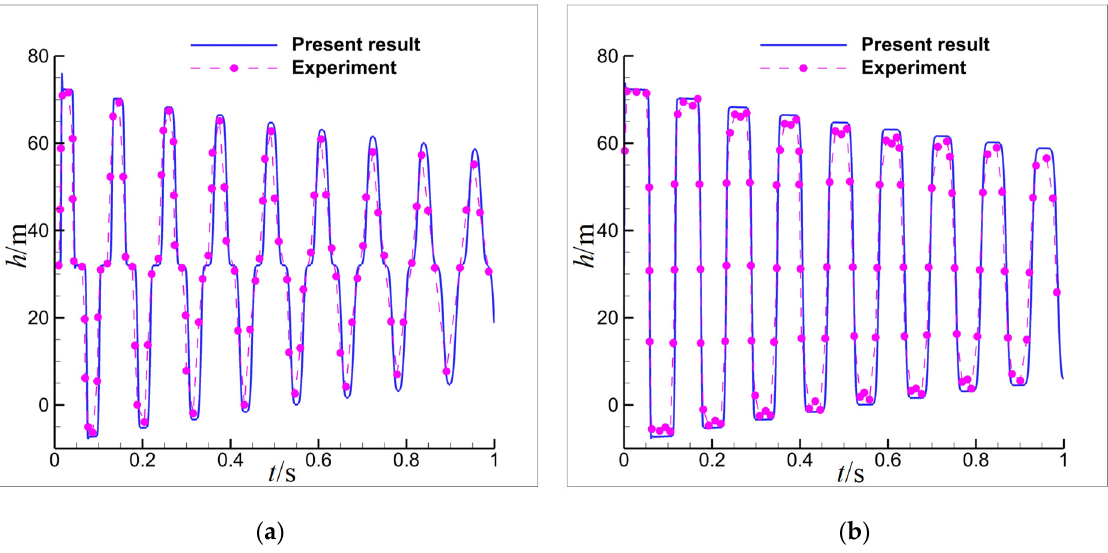
Figure 3. Comparison of water heads between the present simulation and experimental data when V 0 = 0.3 m/s: ( a ) at the midpoint, ( b ) at the valve (endpoint).